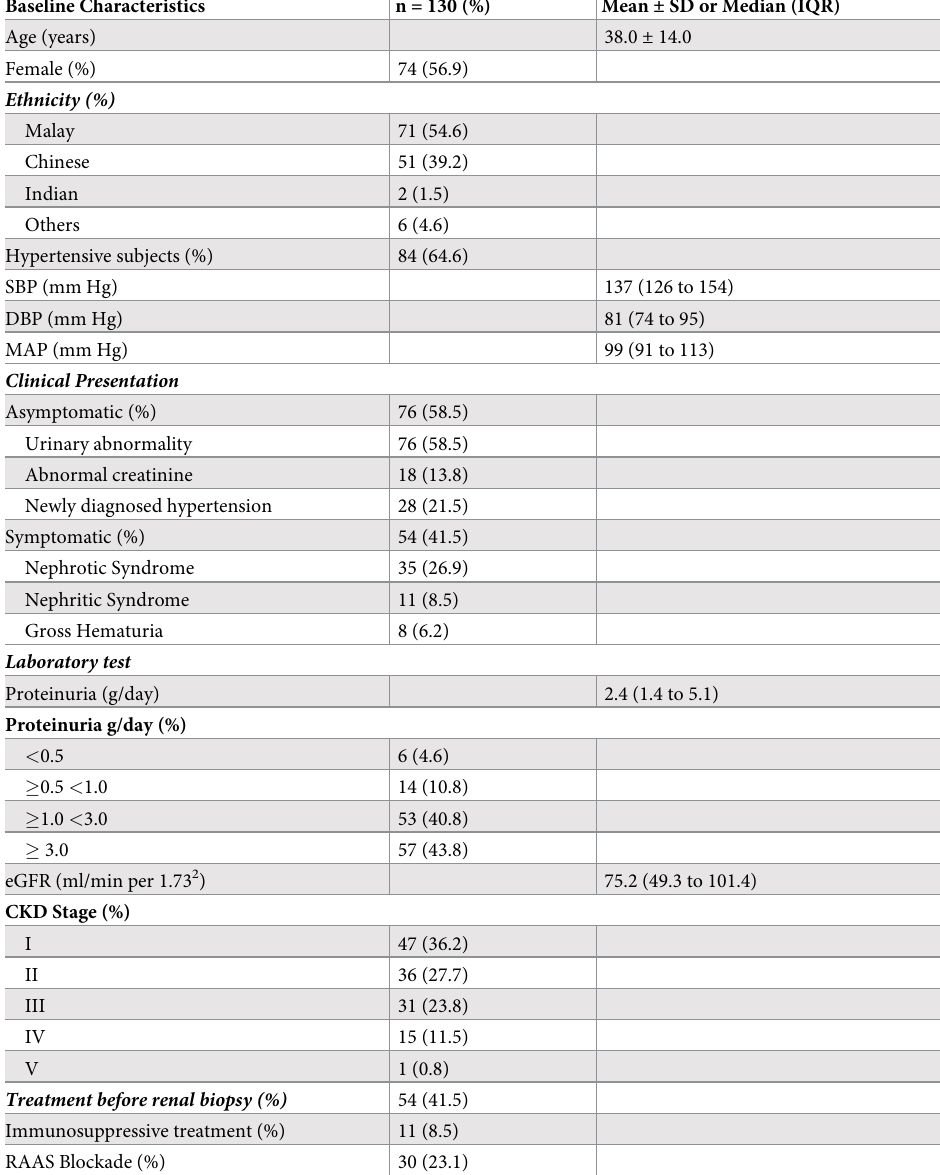
Table 1. Baseline characteristics of patients with IgA nephropathy. Baseline